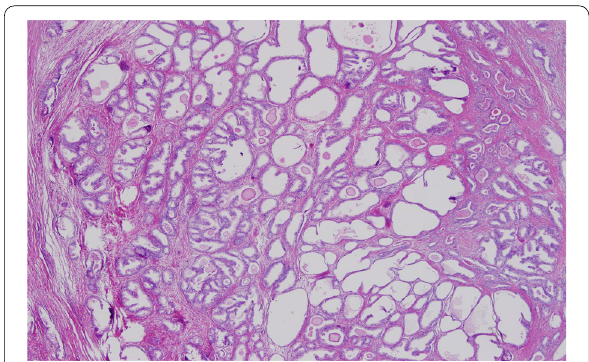
Fig. 2 Microscopic view of the specimen. Benign prostate tissue with hyperplastic change. H&E